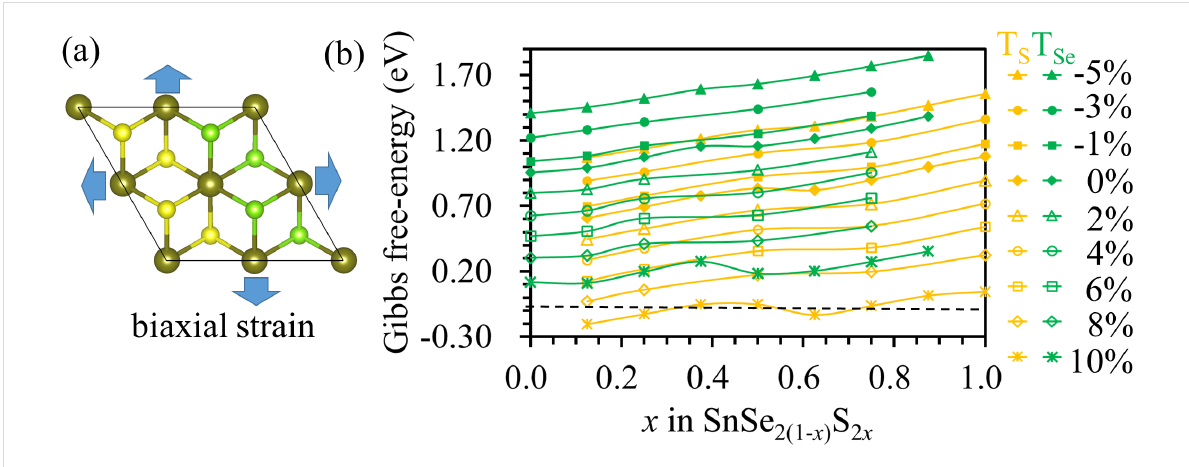
Figure 3: (a) A schematic diagram showing strain applied to SnSe 2(1 − x ) S 2 x monolayer. (b) Evolution of Δ G H for the SnSe 2(1 − x ) S 2 x monolayer with me- chanical strain. The black dashed line indicates a Gibbs free energy of zero.